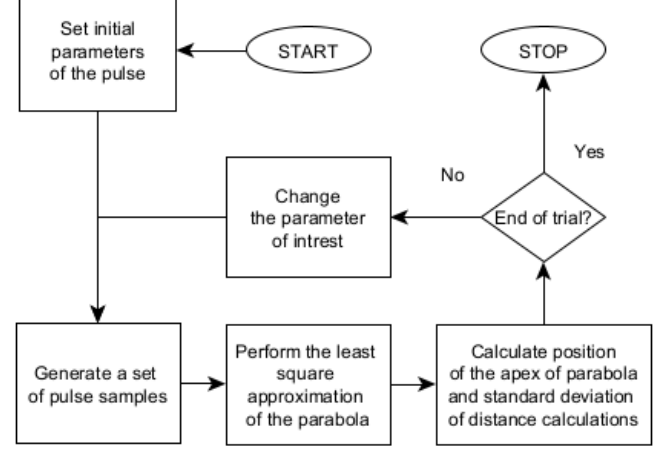
Figure 3. Algorithm of simulation trials.